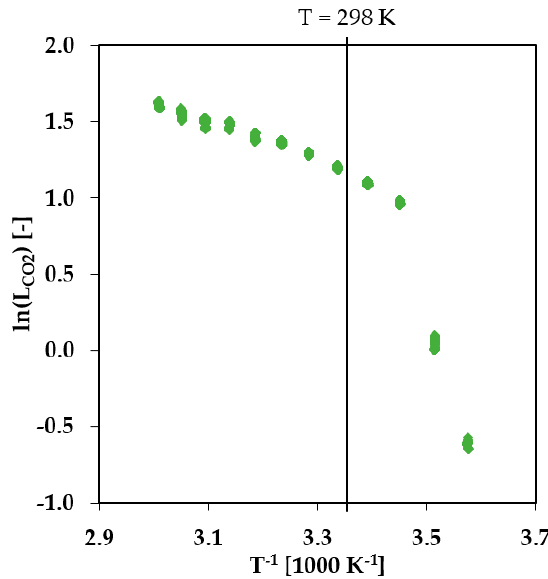
Figure 2. CO 2 single gas transport experiment with PolyActive™ thin film composite membrane at different temperatures. Temperature range 5–60 °C, feed pressure 200–1200 mbar, permeate pressure 0–10 mbar.